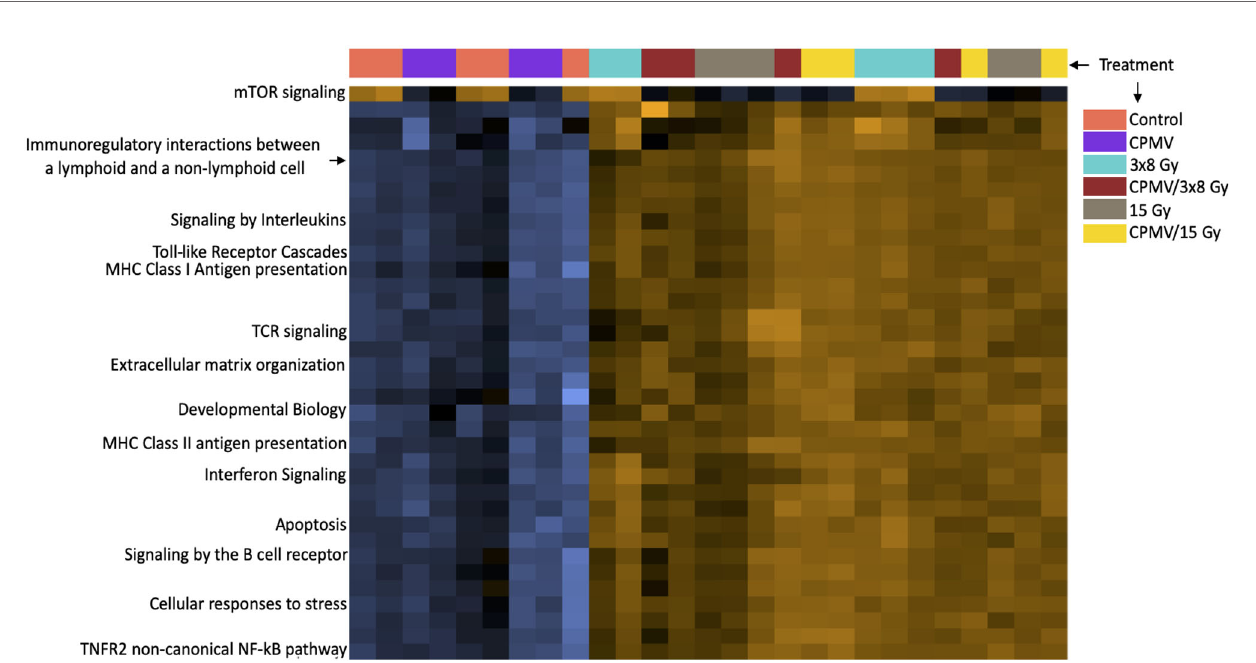
FIGURE 3 | Heatmap of Pathway Expression. Pathway scores are derived from the fi rst principal component of the genes in that pathways normalized expression, and range from -7.7 to 4.5. The NanoString analysis performs a Z-transformation to allow for scores to be displayed on the same scale, with yellow demonstrating high scores with blue demonstrating low scores. (i.e., yellow corresponds to most genes having higher expression in that pathway). The heatmap functions as a simpli fi ed way of seeing how treatment cohorts affect pathways differently, with each column representing an animal. While there are many pathways represented, we have labeled the ones we believe to be of importance such as the T cell receptor signaling pathway, antigen presentation pathways, etc. Many of these pathways demonstrate higher expression n scores in the combinatorial groups than either treatment alone. This is a high-level overview depiction of the mRNA results. This information is not appropriate for statistical analysis, as it is meant to be qualitative, not